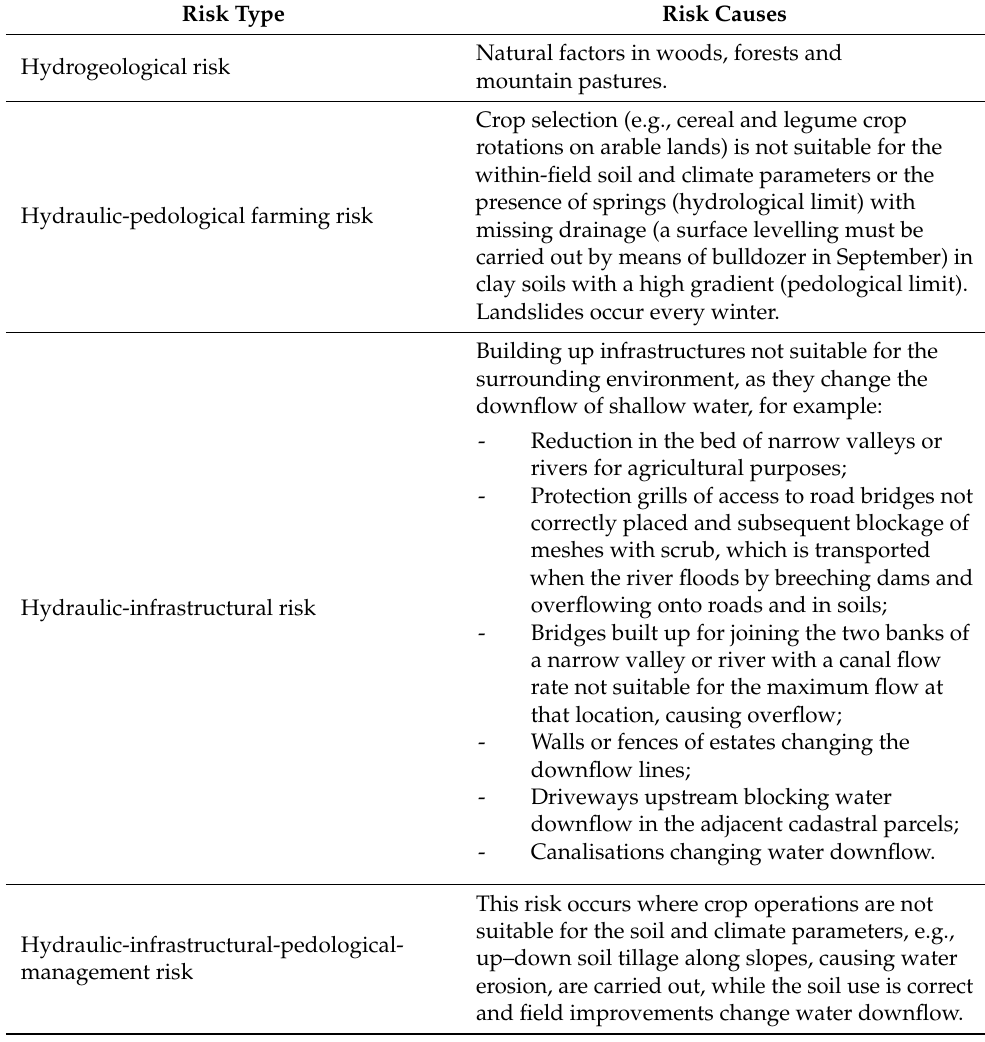
Table 1. Nomenclature proposed for hydrogeological instability risks, based on the three surveyed case studies. Risk Type Risk